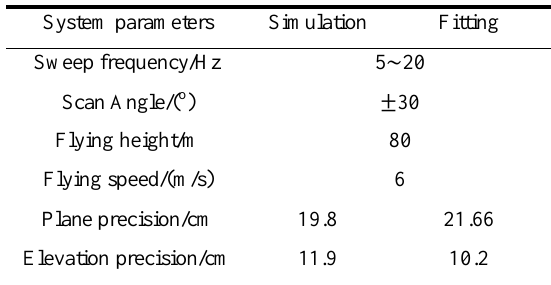
Table 3 Comparison of Accuracy